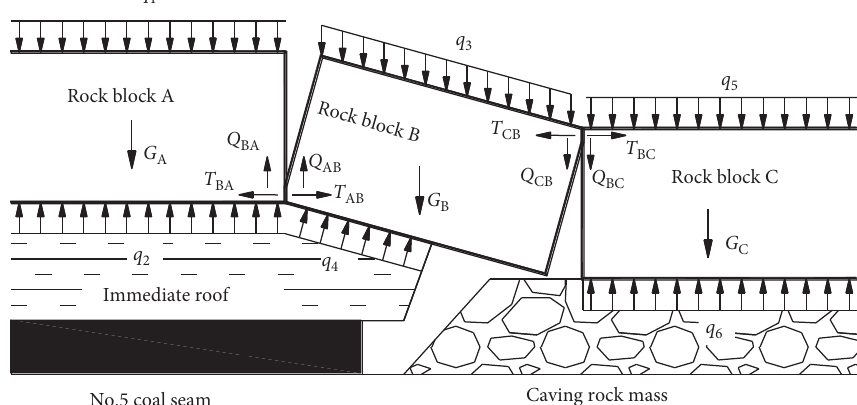
Figure 6: Hinged fracture structure of the sandstone layer. G B , gravity of the rock block B; T AB and T CB , horizontal thrust of the rock block A and C to rock block B; Q AB and Q CB , friction resistance of the rock block A and C to the rock block